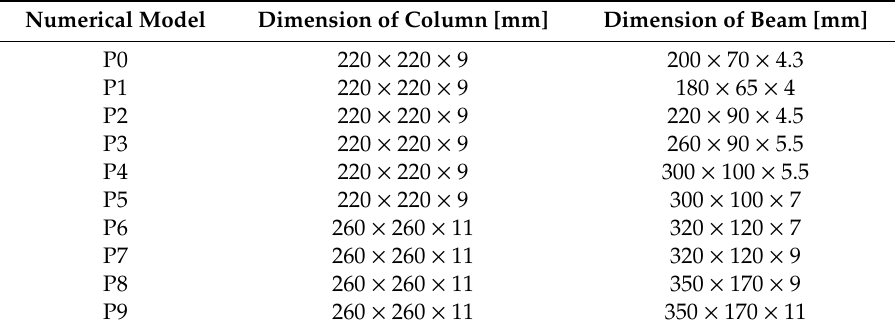
Table 8. Matrix of simulation with different sizes of beams and columns.